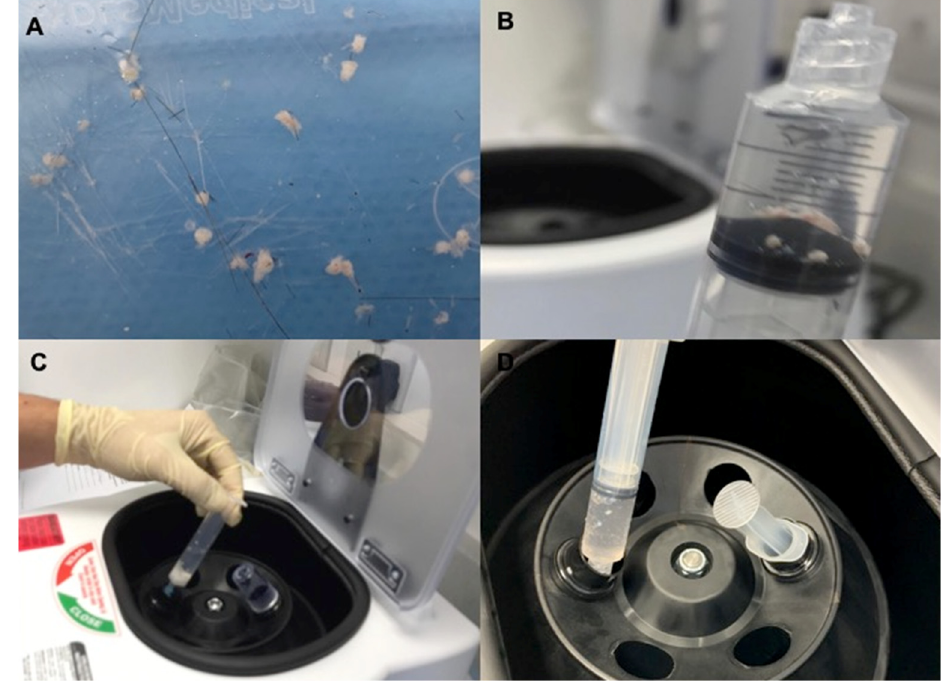
Figure 7. Micro-grafts preparation. Step 2 (Scalp tissues centrifugation). ( A ) Fragments split, ( B ) harvesting of split fragments stored in saline solution, ( C ) centrifugation of two 10mL luer-look syringes containing split fragments, ( D ) solution obtained .